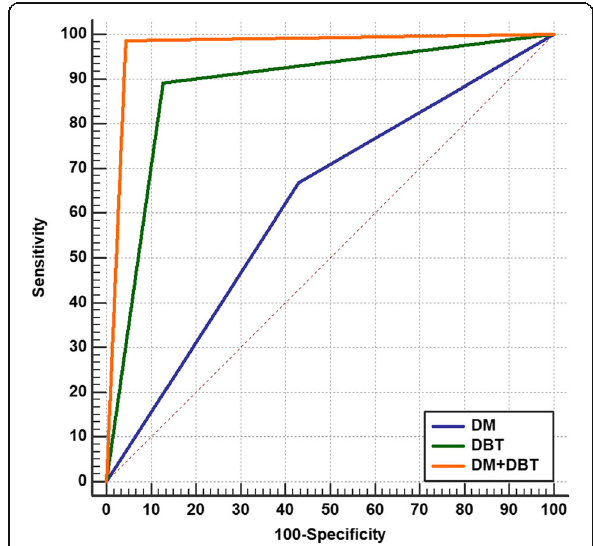
Fig. 2 Comparison of the ROC areas of BI-RADS with DM, BI-RADS with DBT, and BI-RADS with combined DM and DBT for breast cancer diagnosis as evidenced by histopathology as the reference